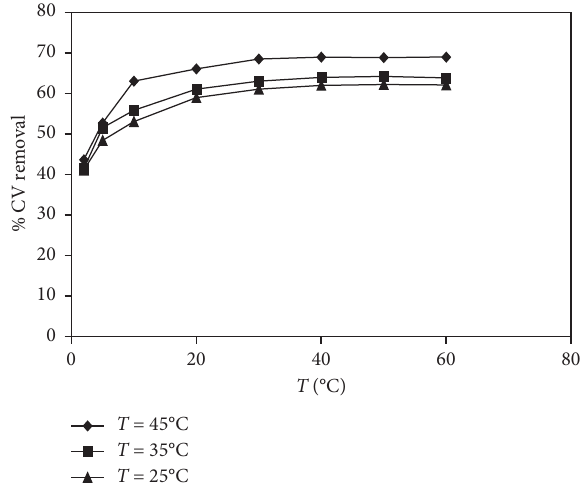
Figure 12: Effect of temperature on the removal of